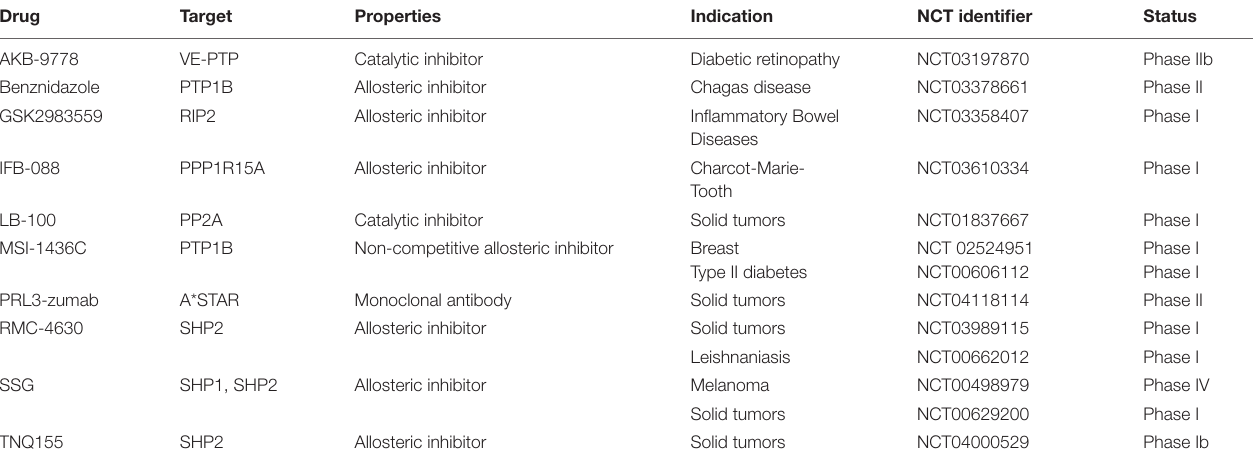
TABLE 2 | Different phosphatase inhibitors under clinical investigation.